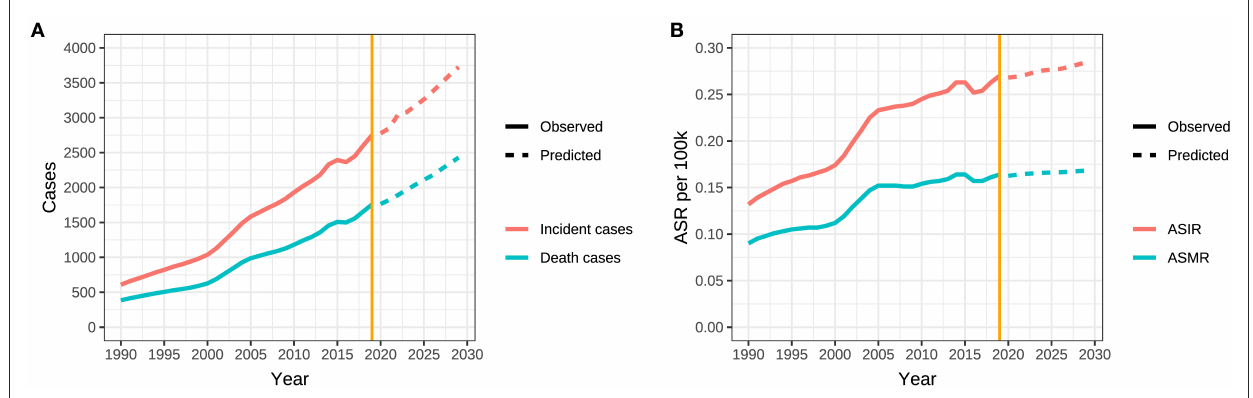
FIGURE7 Trends in observed and predicted incidence, death, ASR of ovarian cancer attributable to hyperglycemia from 1990 to 2029 in China. (A) Trends in observed and predicted incidence and death and (B) Trends in observed and predicted ASR.